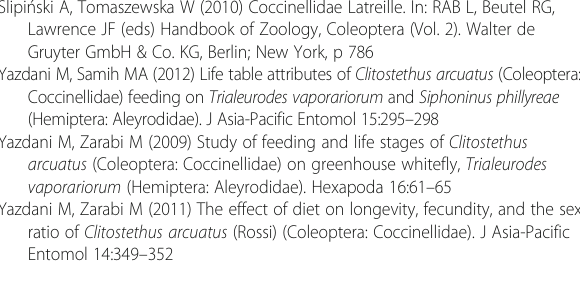
table analysis. (http://140.120.197.173/Ecology/Download/TwosexMSChart.zip). Gerling D, Oscar A, Judit A (2001) Biological control of Bemisia tabaci